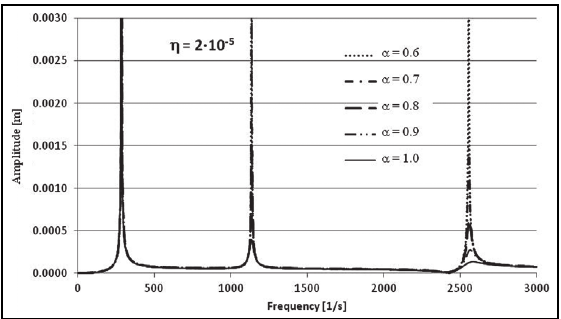
Fig. 2. Amplitude-frequency characteristic η = 2 · 10 − 5 . Fig. 3. Amplitude-frequency characteristic – 1-st resonance.